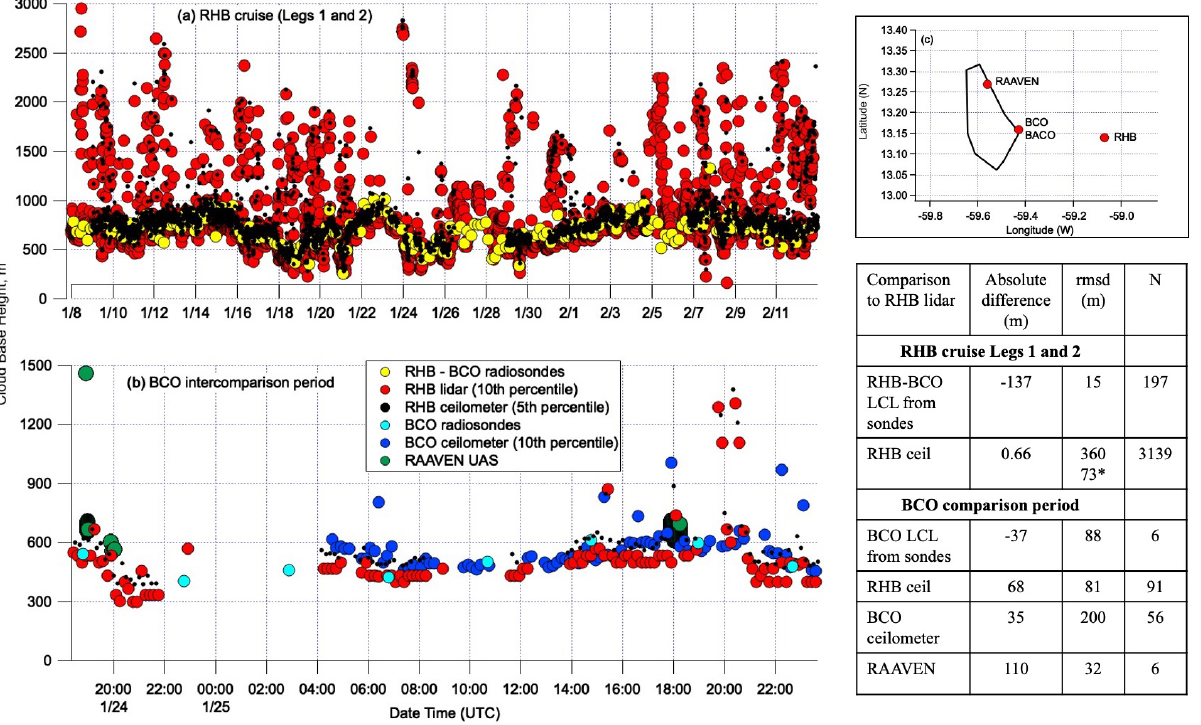
Figure 11. Comparison of cloud base height (CBH) for (a) legs 1 and 2 on board RV Ronald H. Brown ( RHB ) based on LCL calculated from the stitched together RHB − BCO radiosonde record (Eq. 1), the ceilometer, and the Doppler lidar and (b) for the RHB − BCO comparison period (24 January, 18:20–25 January, 23:40) based on the BCO ceilometer, LCL from BCO radiosondes, the RHB ceilometer and microDop lidar, and the RAAVEN UAS flown from Morgan Lewis (30km north of BCO). Locations of the RAAVEN launch site, BCO, and RHB are shown in (c) . The average of the absolute differences and root mean square differences (RMSDs) are shown in the table inset relative to the RHB lidar-derived CBH. N indicates number of samples used in the comparison. * RMSD for RHB ceilometer – RHB microDop lidar with CBH greater than 1000m removed from